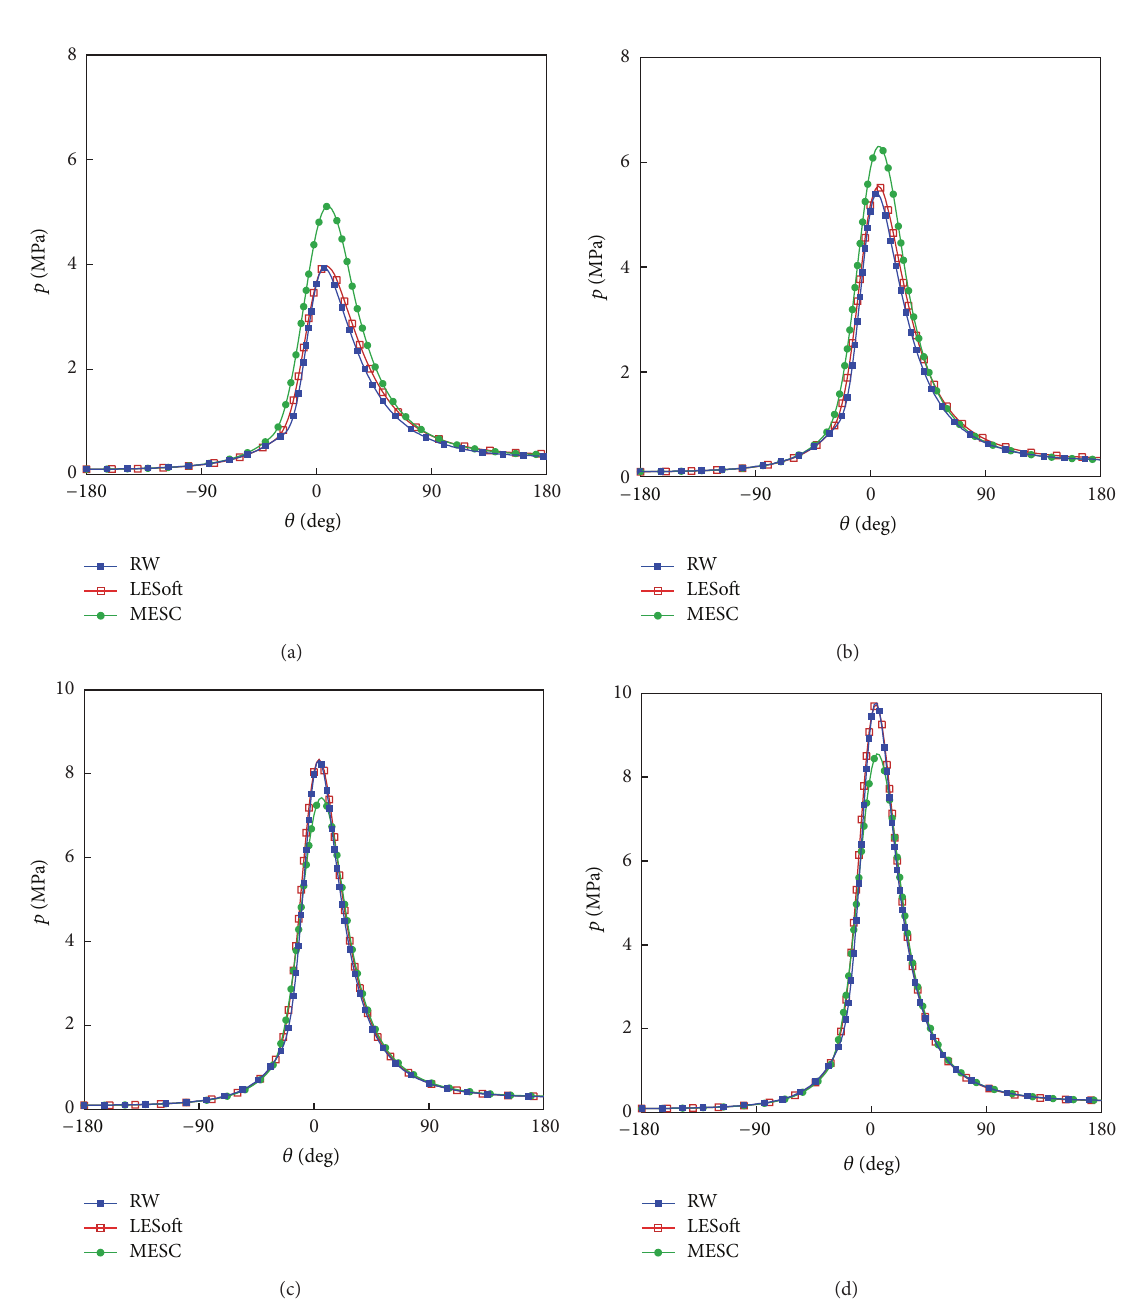
Figure 15: Profiles of pressure for compression ratios of 6 (a), 8 (b), 12 (c), and 14